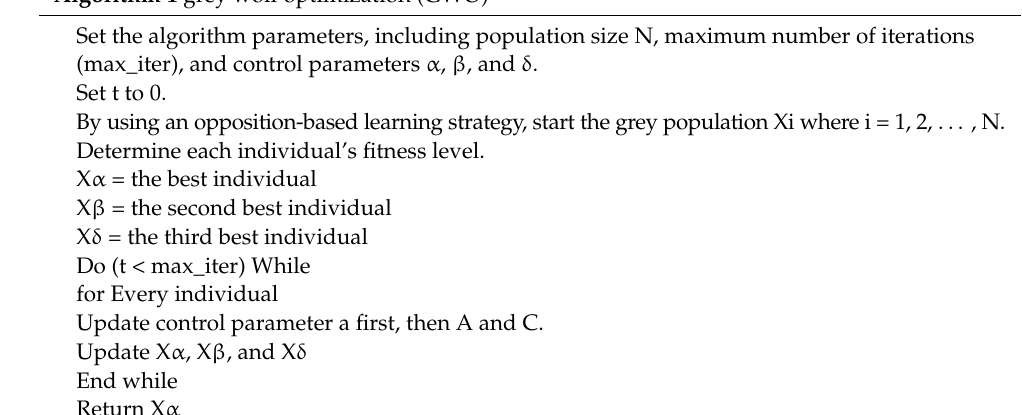
Algorithm 1 grey wolf optimization